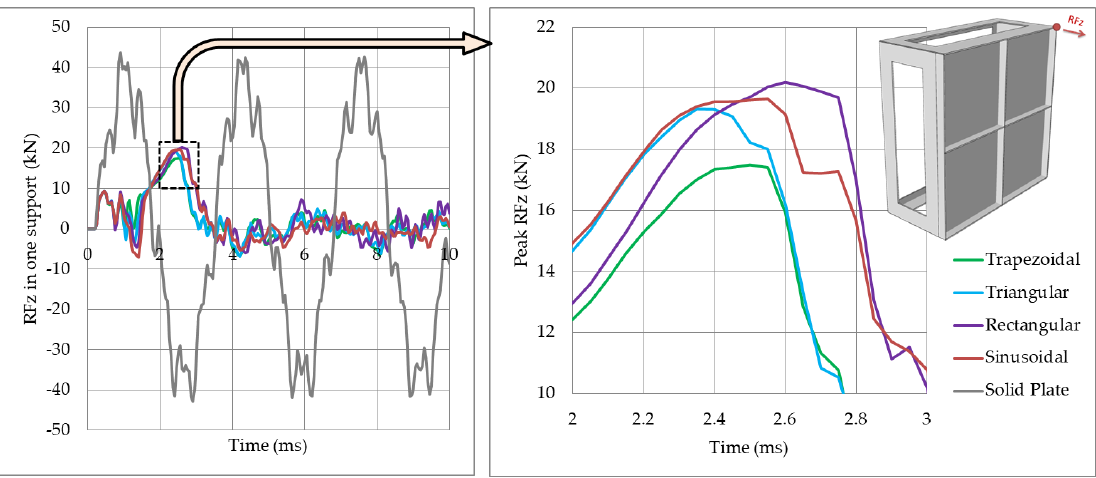
Figure 10. The effect of corrugation shape/topology on the nodal reaction force time-history (in one support) when the sandwich panel is subjected to 0.5 kg of TNT at R = 0.5 m (BI-5).